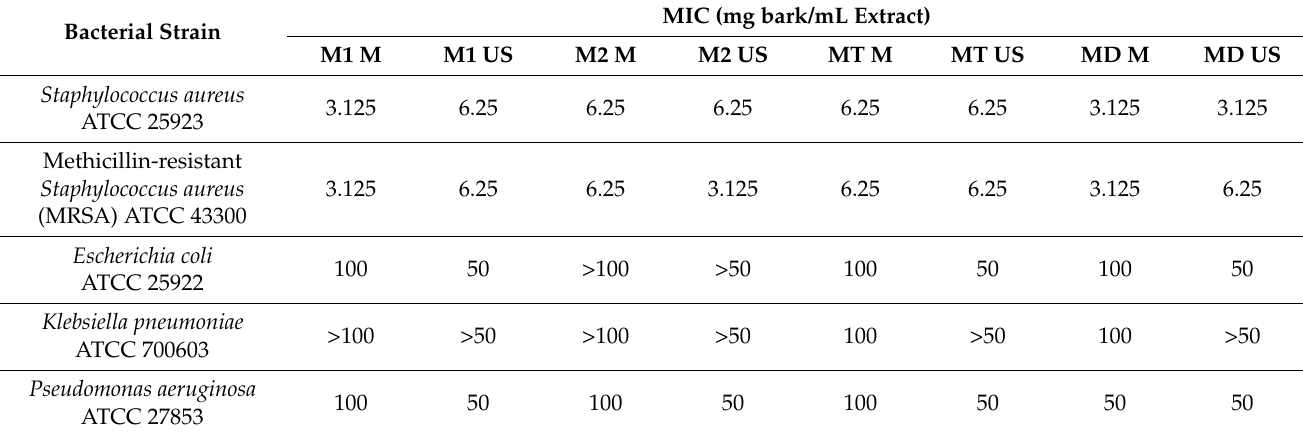
Table 3. MICs of the tested extracts expressed as mg vegetal material/mL